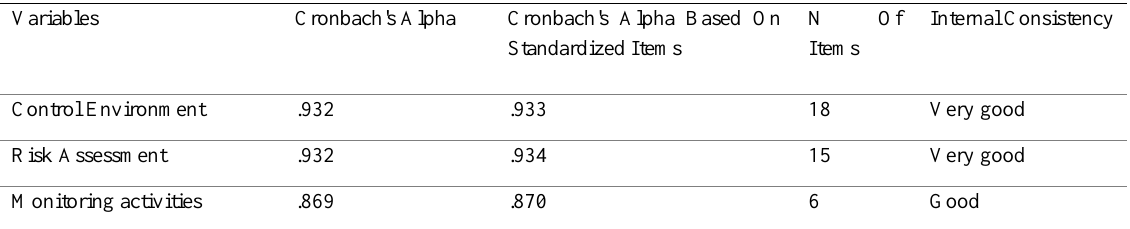
Table 2: Reliability test, Cronbach’s Alpha